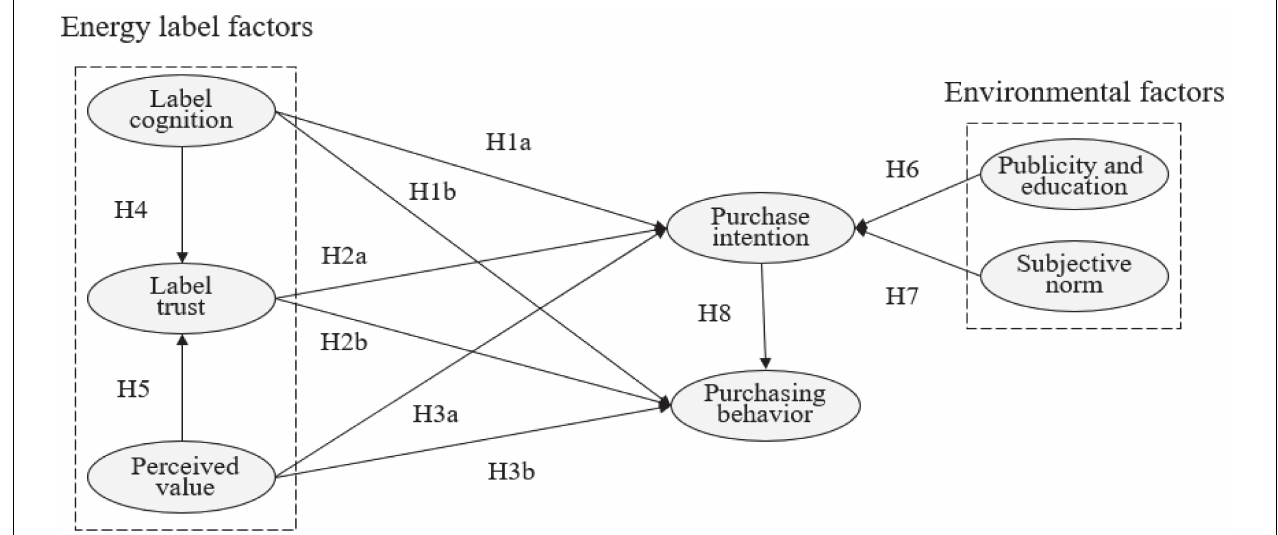
FIGURE 1 | Proposed conceptual model.